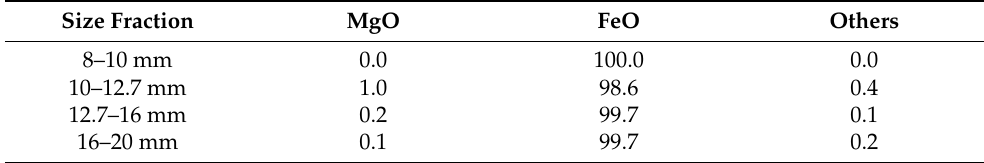
Table 4. Average compositions (in wt.%) for wüstite after the reduction-softening tests for different- sized pellets.